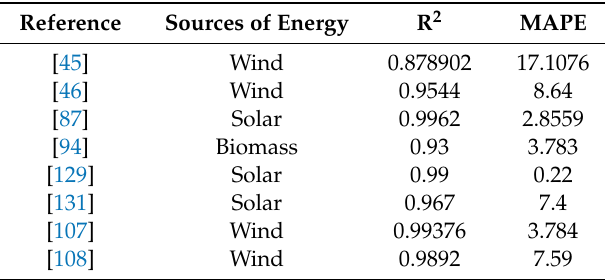
Table 9. Values of R 2 and